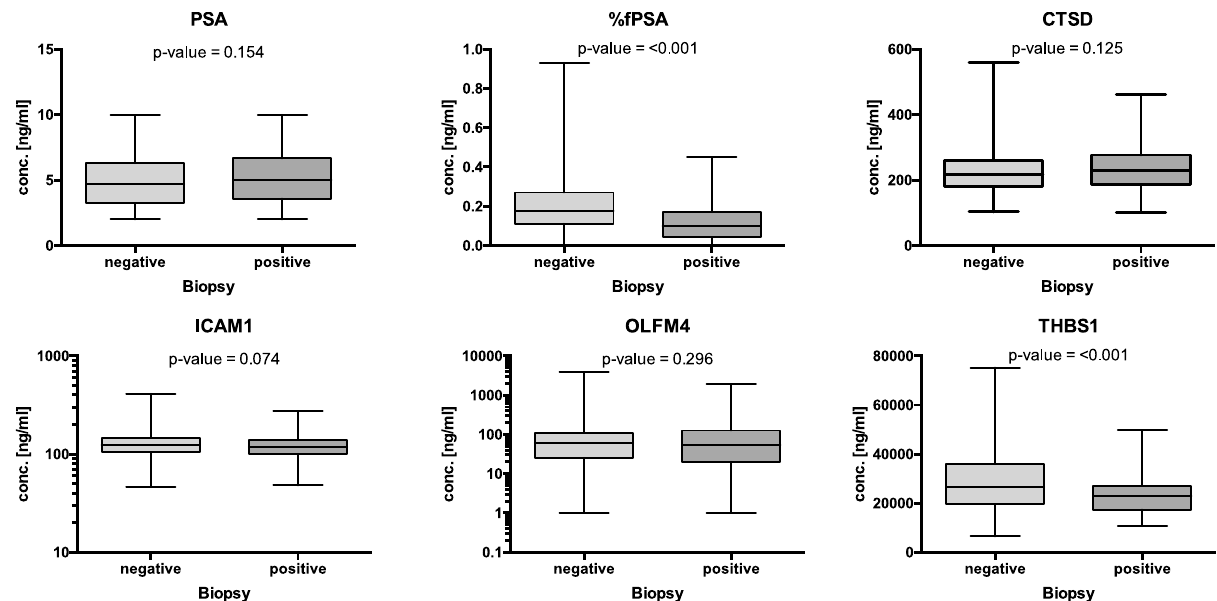
Fig 3. Univariate analysis of individual parameters. Box plots show the concentration of PSA, %fPSA, CTSD, ICAM1, OLFM4, and THBS1 in PCa positive and negative samples.